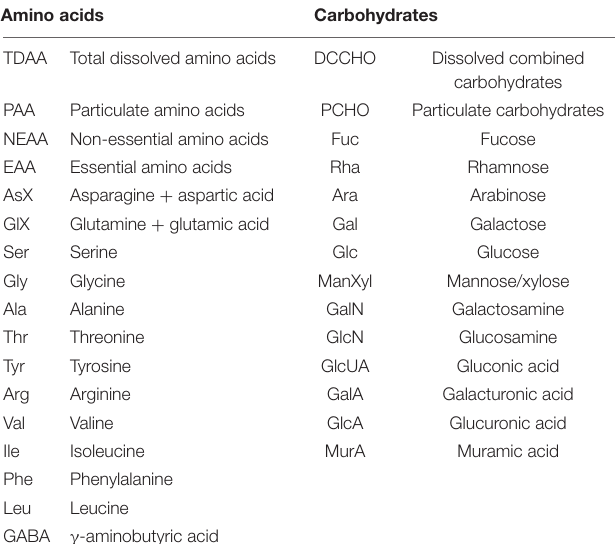
TABLE 1 | Glossary of abbreviations of sub-classes and individual amino acids and